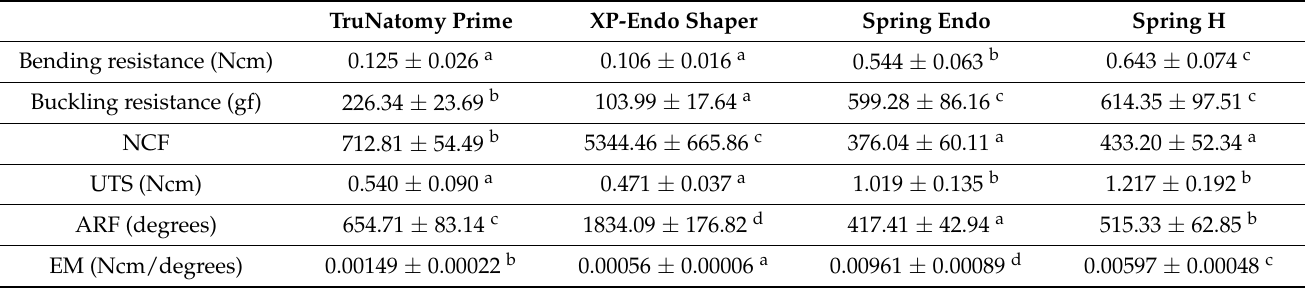
Table 2. Mechanical test results (mean ± standard